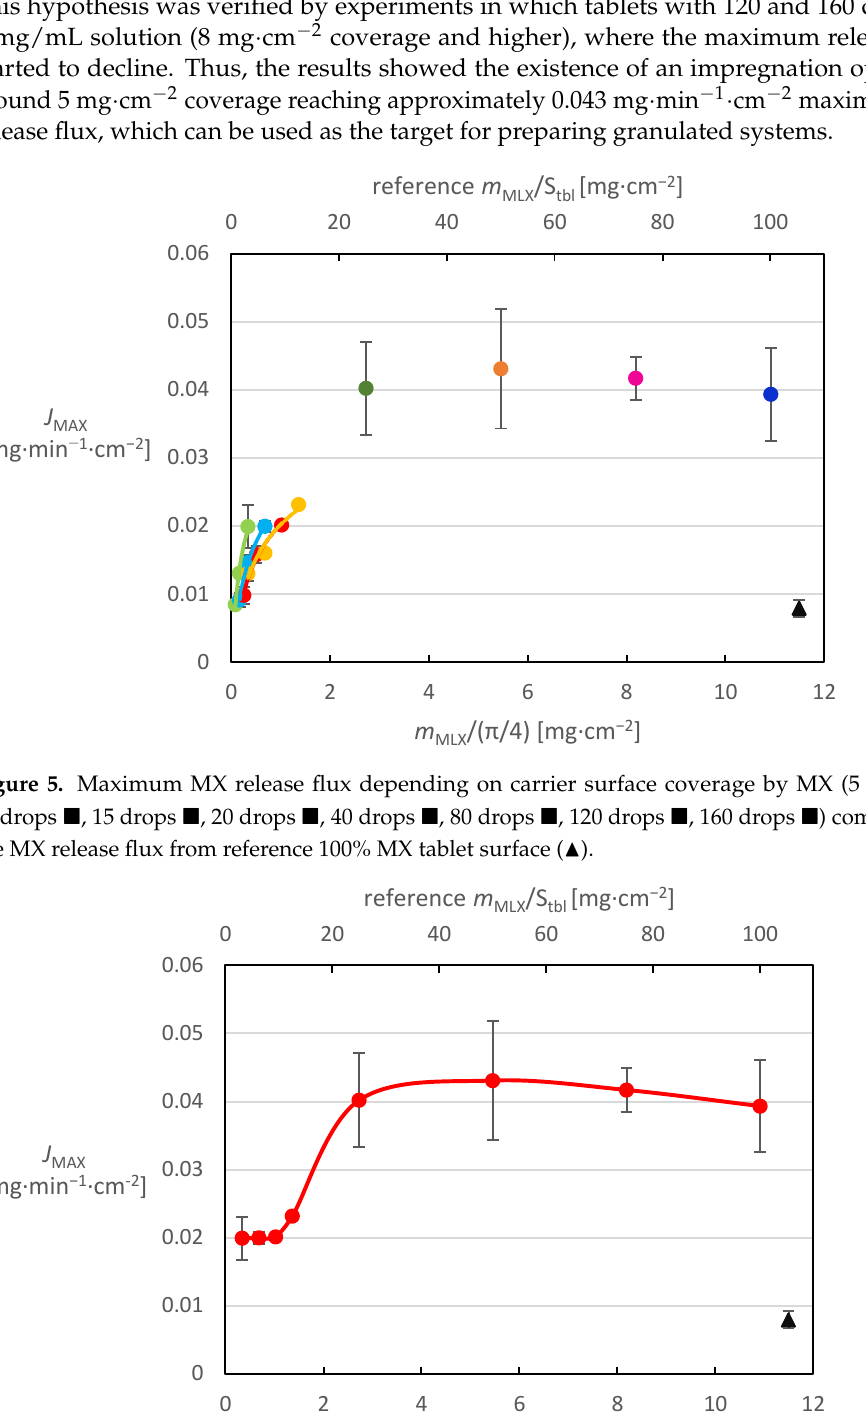
Figure 6. Maximum MX release flux depending on carrier surface coverage by MX for planar surface impregnated by 8 mg/mL MX solution ( ■ ) compared to the flux from reference 100% MX tablet surface ( ▲ ).